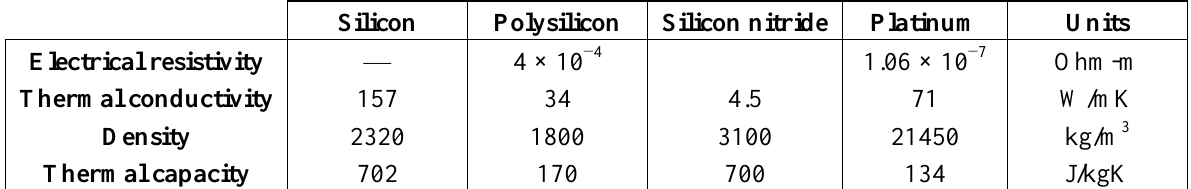
Table 1. Material properties of a micro-heater used in FEM thermal simulation.